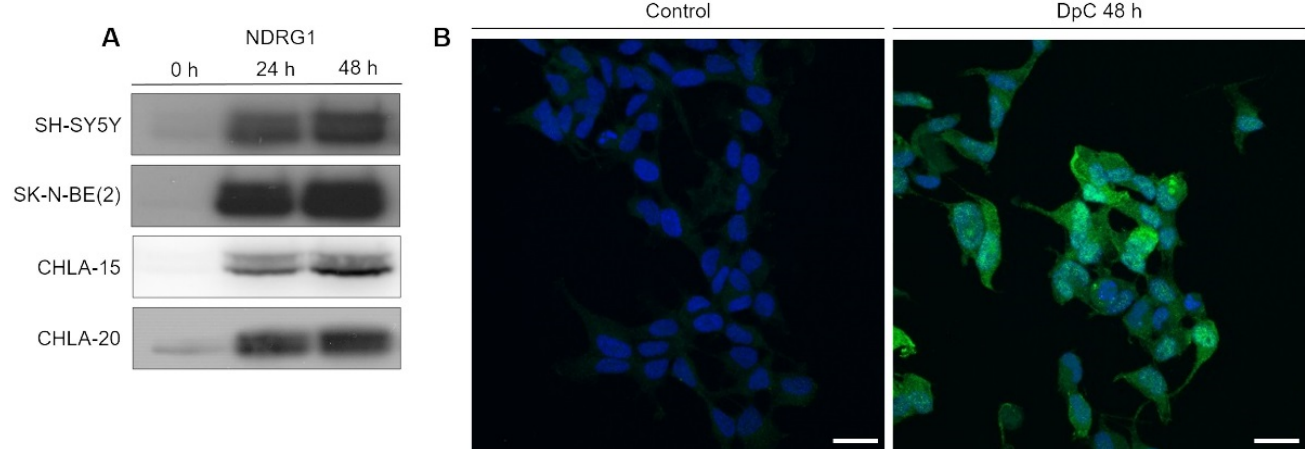
Figure 1. NDRG1 is upregulated in neuroblastoma cells in response to iron-chelation therapy by DpC. ( A ) Immunoblotting of NDRG1 protein levels in neuroblastoma cell lines treated with 20 µ M (SH-SY5Y, SK-N-BE(2)) or 2 µ M (CHLA-15, CHLA-20) DpC. Representative images of three independent experiments. Source data are provided in Figure S1. ( B ) Massive increase of NDRG1 (green) expression in DpC-treated cells in comparison to control. Immunofluorescence micrographs of SH-SY5Y cells treated with 20 µ M DpC for 48 h. Nuclei counterstained with Hoechst 33342 (blue). Scale bar: 20 µ